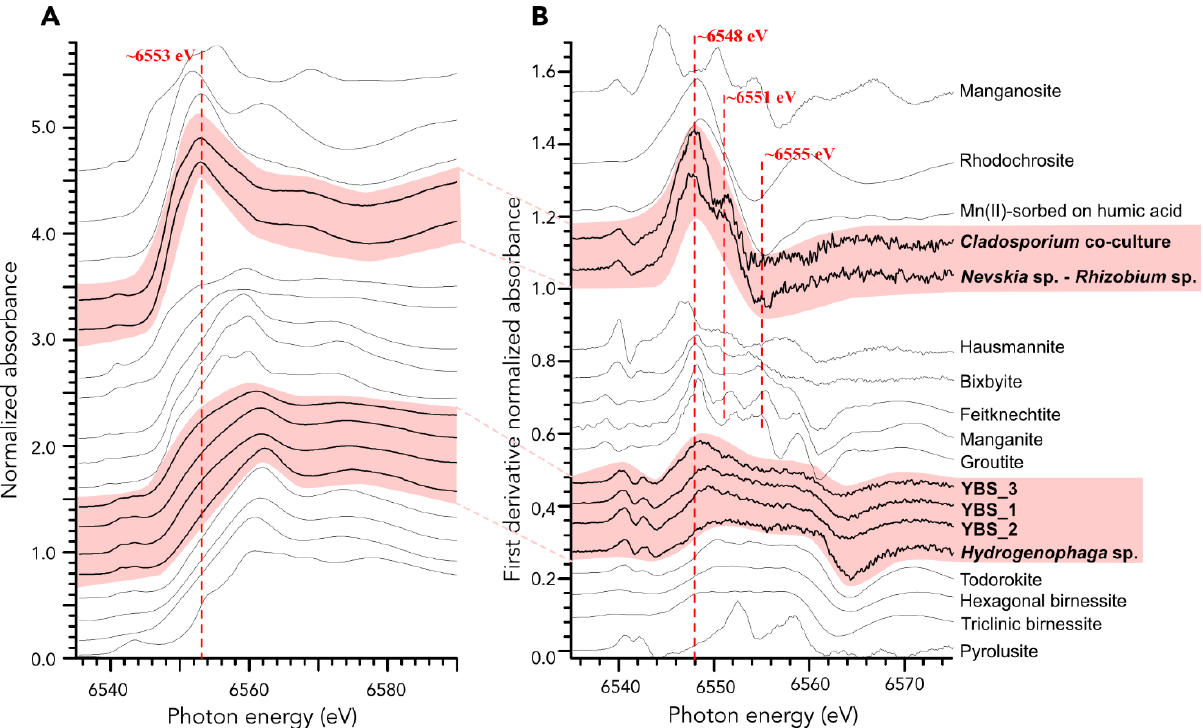
Figure 8. Mn K-edge XANES spectra. ( A ) Samples and reference compounds. ( B ) First derivatives of ( A ). The spectra of feitknechtite ( β -MnOOH), manganite ( γ -MnOOH), and groutite ( α -MnOOH) were taken from Bargar et al. (2005) [6], while those of todorokite, rhodochrosite, and two hydrous layered phyllomanganates (hexagonal birnessite and triclinic birnessite) from Feng et al. (2010) [30] and Yu et al. (2017) [31], respectively.